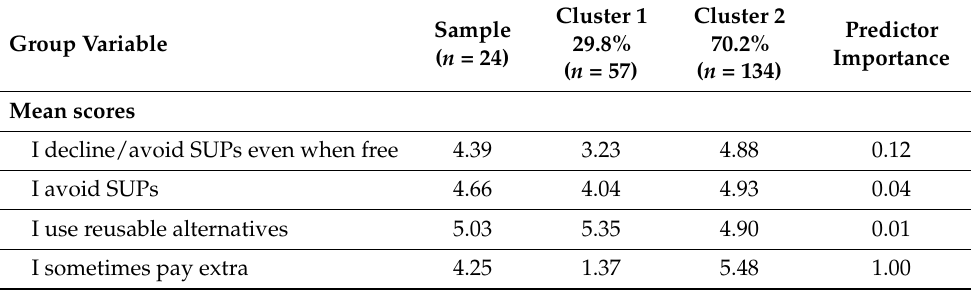
Table 5. SUP behaviour-based clusters for